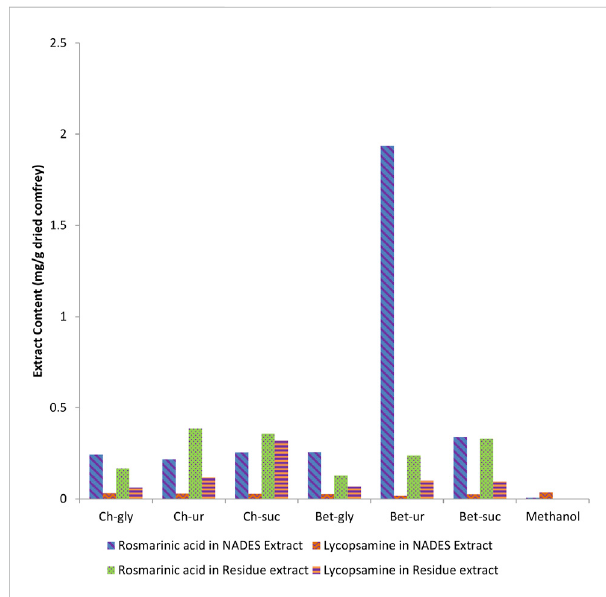
Comparison of rosmarinic acid and lycopsamine contents obtained by extraction of comfrey leaves in different NADES. The residue was further re-extracted using methanol to assess the contents of the bioactive